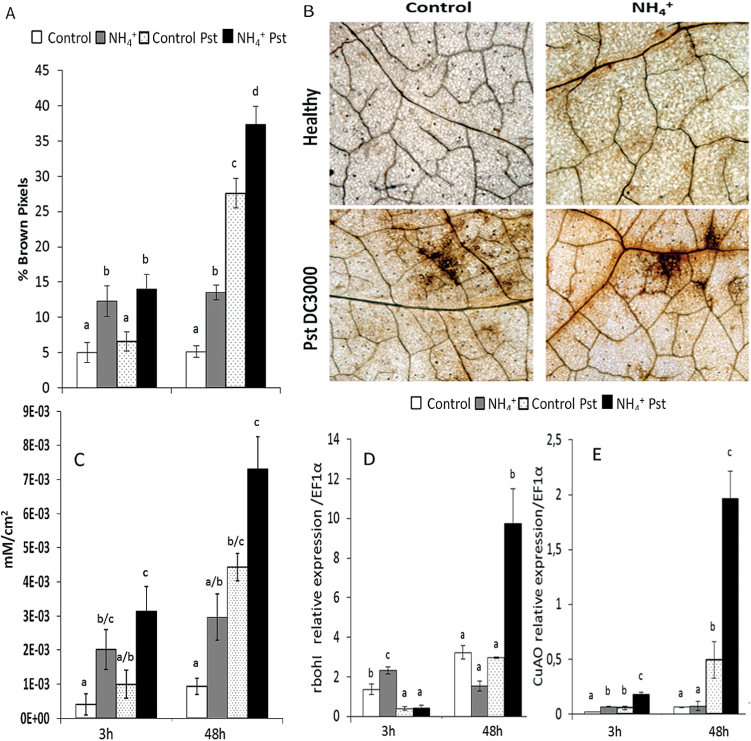
Effect of NH4
+ nutrition on the oxidative burst upon Pst infection. Plants were grown and inoculated as described in Fig. 2. H2O2 accumulation was visualized by DAB staining. Quantification was performed by determining the number of brown pixels on digital photographs of leaves at 3 and 48 hpi (A). Representative photographs were taken of H2O2 accumulation in control and N-NH4
+ plants in the absence of pathogens, as well as 48 hpi (B). Data show average values ±SE (n=20) of the relative number of brown or yellow pixels per photograph. H2O2 concentrations were quantified by xylenol orange analysis (C). Total RNA was isolated from leaves at 3 and 48 hpi and was converted into cDNA and subjected to a qRT-PCR analysis. The relative level of (D) rboh1 and (E) CuAO was analysed in the control and N-NH4
+ plants. The results were normalized to the EF1α gene expression measured in the same samples. Letters indicate significant differences between treatments at each time point (P<0.05; least-significant difference test). (This figure is available in colour at JXB online.)